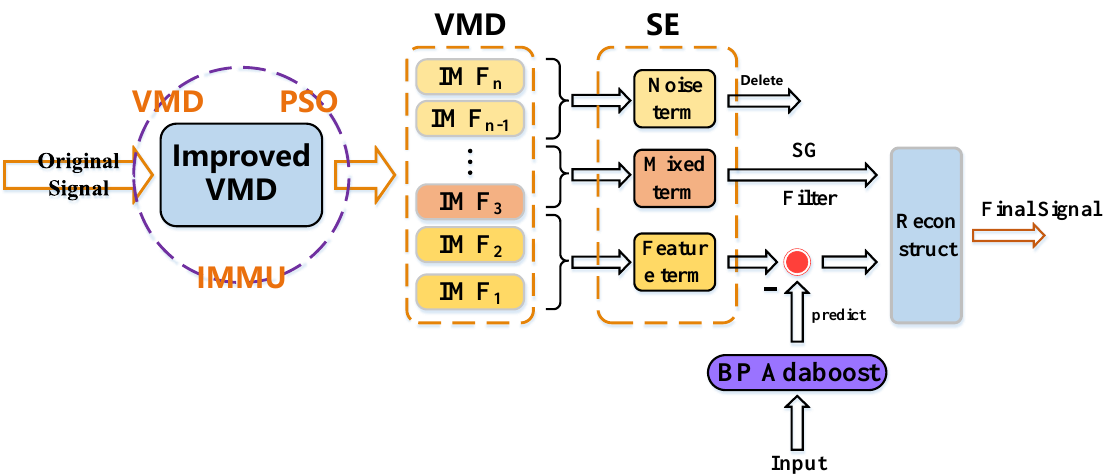
Figure 8. Temperature compensation model based on IPSO-VMD and BP-Adaboost.